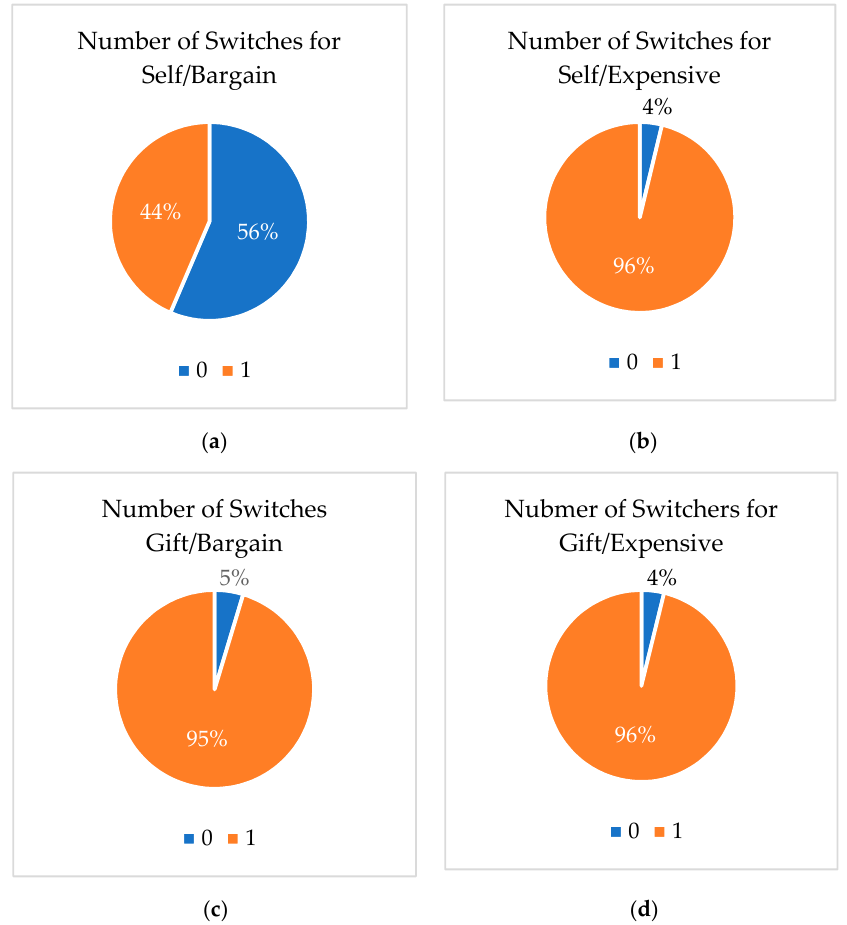
Figure 2. Number of inconsistent decisions of Plant Buyer Switchers and Non-Switchers by the treatment group: ( a ) Self Purchase at Bargain price; ( b ) Self Purchase at Getting Expensive price; ( c ) Gift Purchase at Bargain price; ( d ) Gift Purchase at Getting Expensive price. Table 5. Marginal effect estimates from four binary logit models summarizing the effects of the reported bargain and getting expensive prices on the switching behavior between plant buyer switchers and plant buyer non-switchers ( n = 1813).